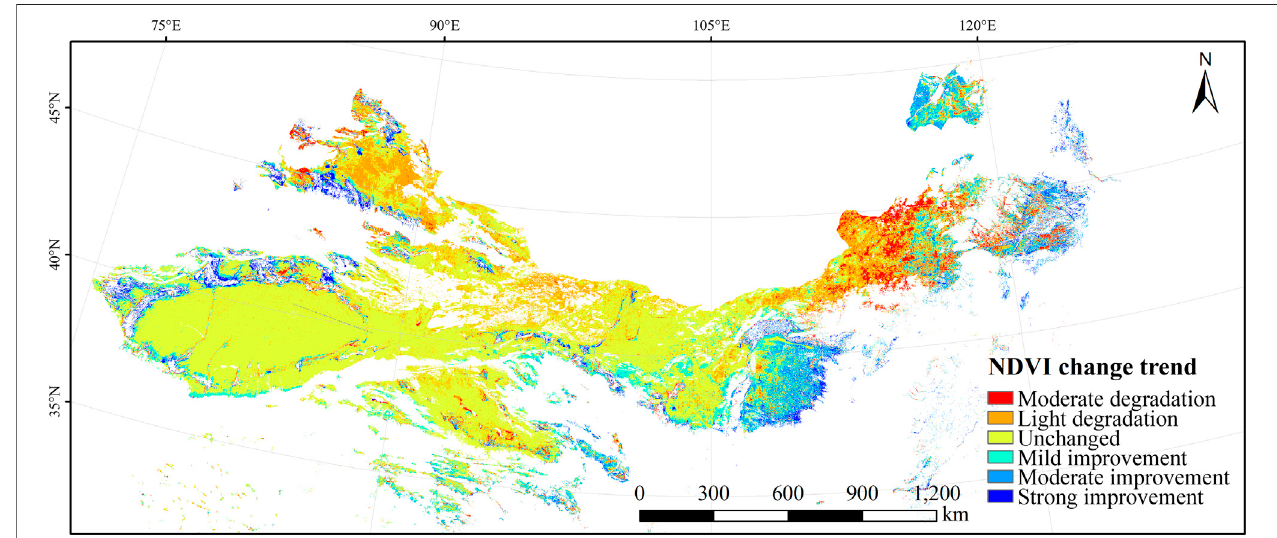
FIGURE 4 | Spatial distribution of the changes in the normalized-difference vegetation index (NDVI) for the six desert types in northern China from 1998 to 2015.